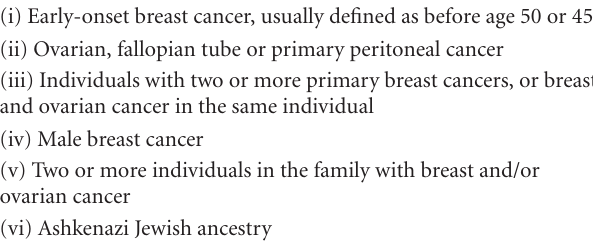
Table 2: Clinical features that warrant referral for genetic testing for BRCA1/2